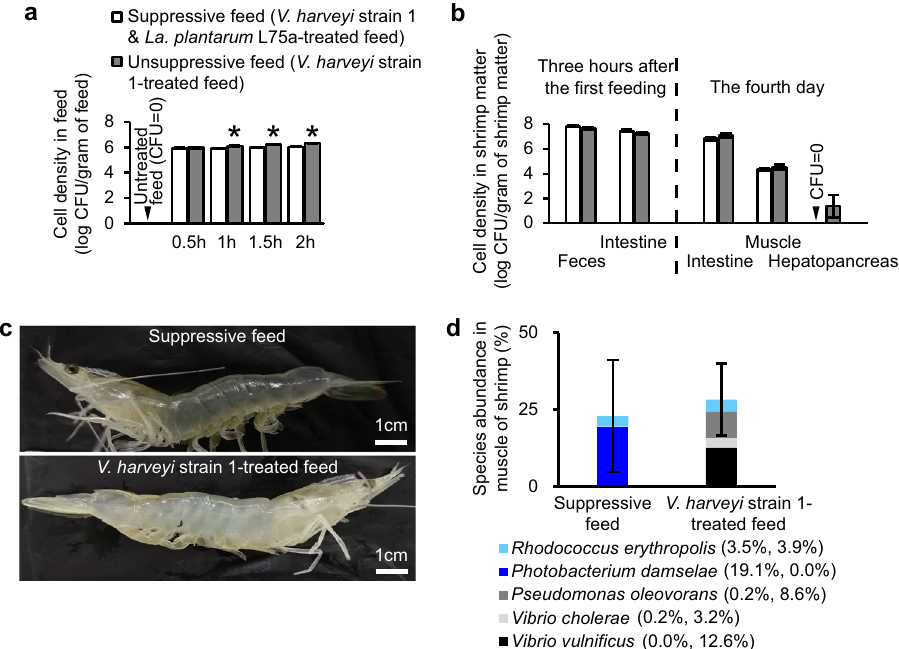
Figure 3. Impact of V. harveyi strain 1 on feed pellets and on Li. vannamei . The feed pellets were treated with a suspension of V. harveyi strain 1 after pre-mixing with (suppressive feed) or without La. plantarum L75a-fermented broth. ( a ) Impact of V. harveyi strain 1 on the bacterial cell density in feed pellets, which was determined on TCBS agar every half hour in a duration of 2 h. *Statistically significant difference compared with the corresponding suppressive feed treatment scored at the same time. ( b ) Bacterial cell density in the feces and intestine of Li. vannamei after 3 h of feeding (left, the second feeding test) and in the intestine, muscle and hepatopancreas after 4 days of feeding (right, the third feeding test), which was determined on TCBS agar. The dotted line separated the results from the two independent tests. ( a ) and ( b ) share the same legends. ( c ) The health status of Li. vannamei fed with V. harveyi strain 1-treated feed for 4 days (the third feeding test): the diseased Li. vannamei (fed without La. plantarum supplementation, lower image) exhibited acute whitish- opaque muscle necrosis, while the shrimp fed with the suppressive feed (with La. plantarum supplementation, upper image) possessed clear and transparent muscle. These muscle samples were also determined for the percentage of abundance of bacterial species based on the 16S rRNA gene amplicon sequencing ( d ); the detected species without designated species names and/or with mean percentage lower than 3% were not shown; the first and second numbers in the legend represent the percentage of abundance of the corresponding species detected in the muscle of Li. vannamei fed with the suppressive feed and V. harveyi strain 1-treated diets, respectively. Error bars represent S.E.M. ( N = 9 ( a ), 8 ( b ) and 3 ( d